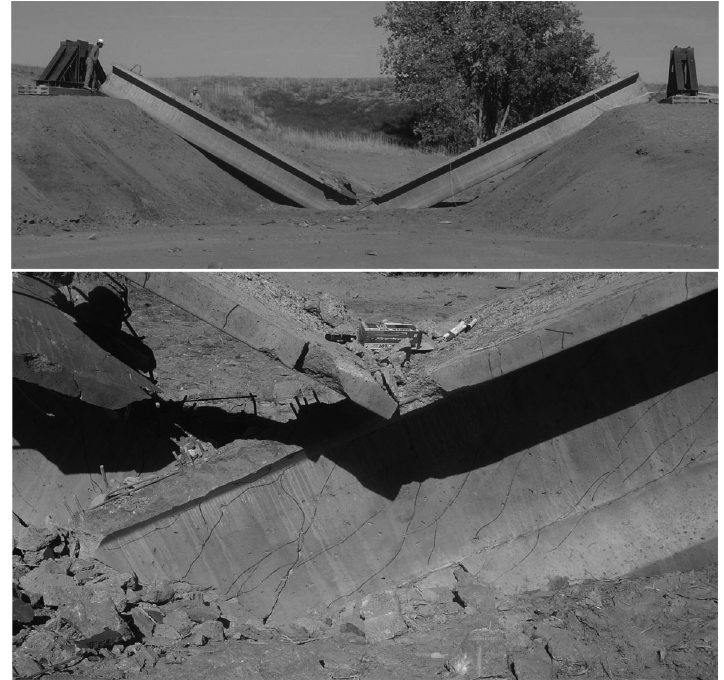
Fig. 12. Damage from the blast below the